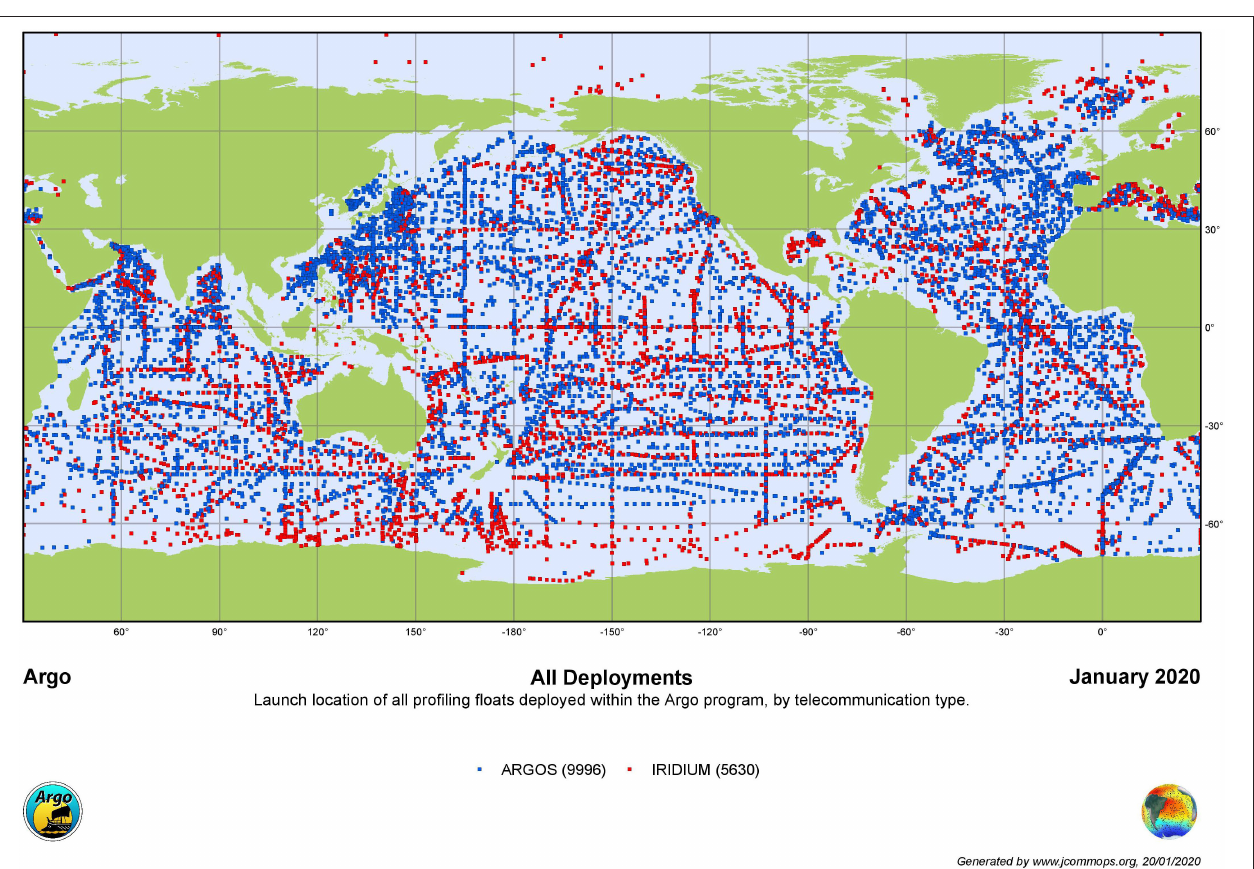
FIGURE 3 | Argo’s geographical coverage by telecommunication type. This map shows the launch location of all floats deployed within the Argo Program, as of January 2020. The red and blue dots denote floats that used Iridium and ARGOS telecommunications, respectively. [Source: JCOMMOPS].